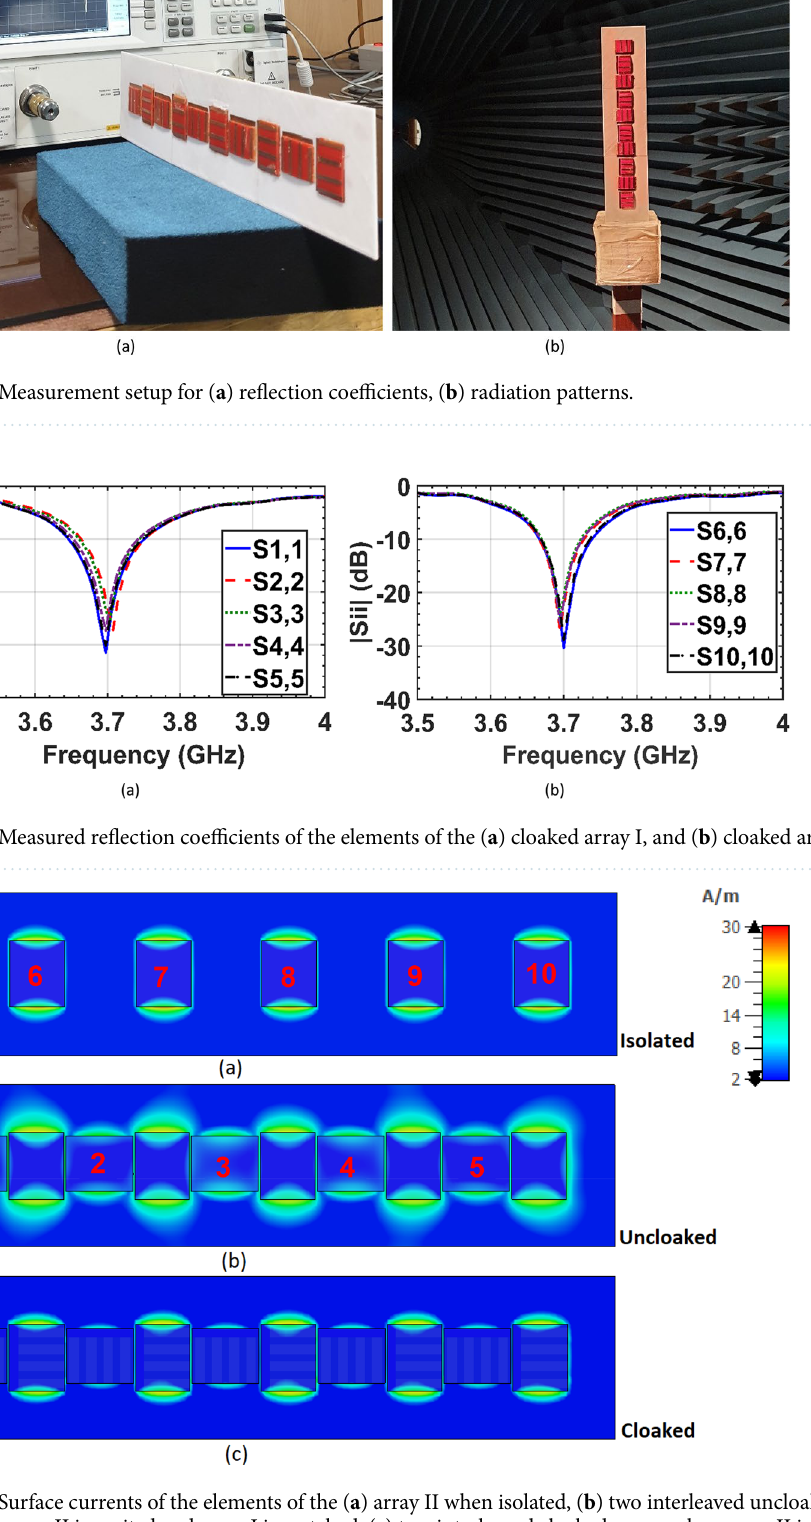
Figure 12. Surface currents of the elements of the ( a ) array II when isolated, ( b ) two interleaved uncloaked arrays when array II is excited and array I is matched, ( c ) two interleaved cloaked arrays when array II is excited and array I is